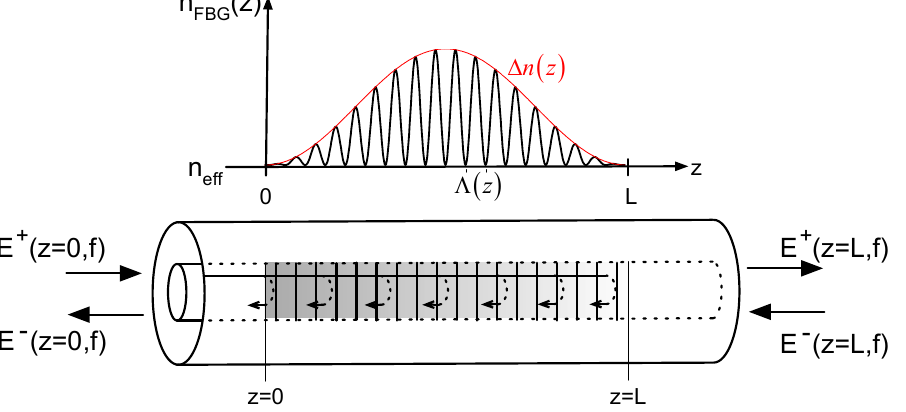
Figure 1. Nomenclature for the parameters of an arbitrary FBG of length L and for the electromagnetic optical fields at the two extremes (the grating period of the perturbation has been increased for illustrative purposes).